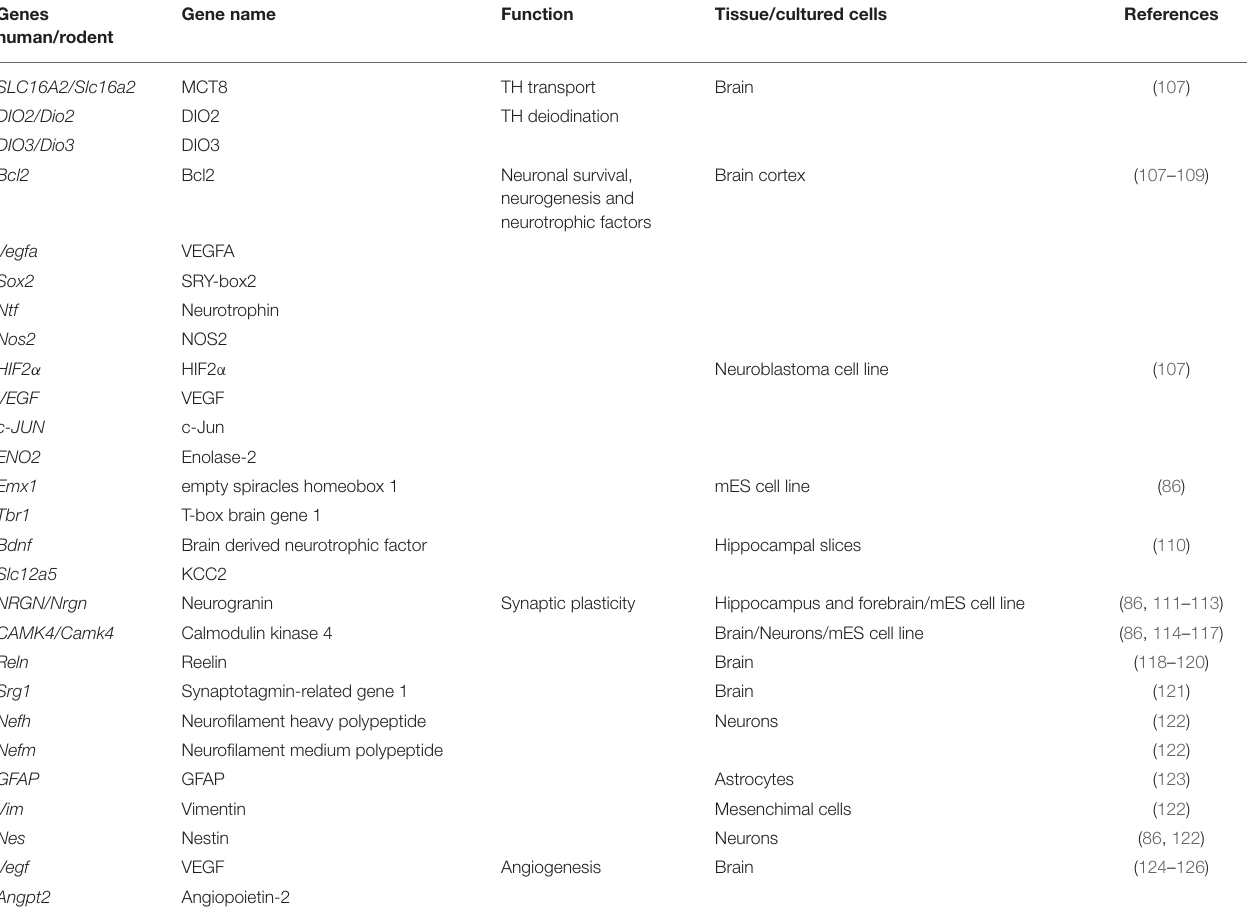
TABLE 1 | List of genes regulated by thyroid hormones involved in their transport into the brain, mechanisms of tissue repair, and neuronal plasticity following ischemic stroke. Genes